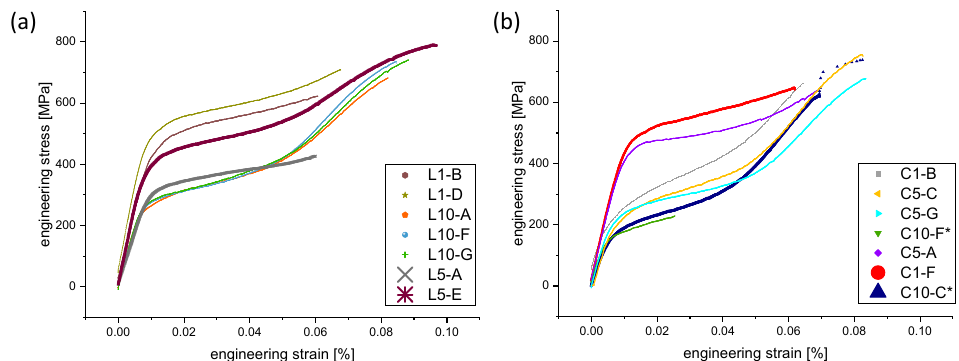
Figure 8. Engineering stress–strain curves from quasi-static tests of L- ( a ) and C-type ( b ) specimens. The microstructure and fracture surface of the highlighted specimens (curves in bold) were investi- gated in detail (see Figure 7). The experimental tests for the specimens marked with * were manually stopped before failure.